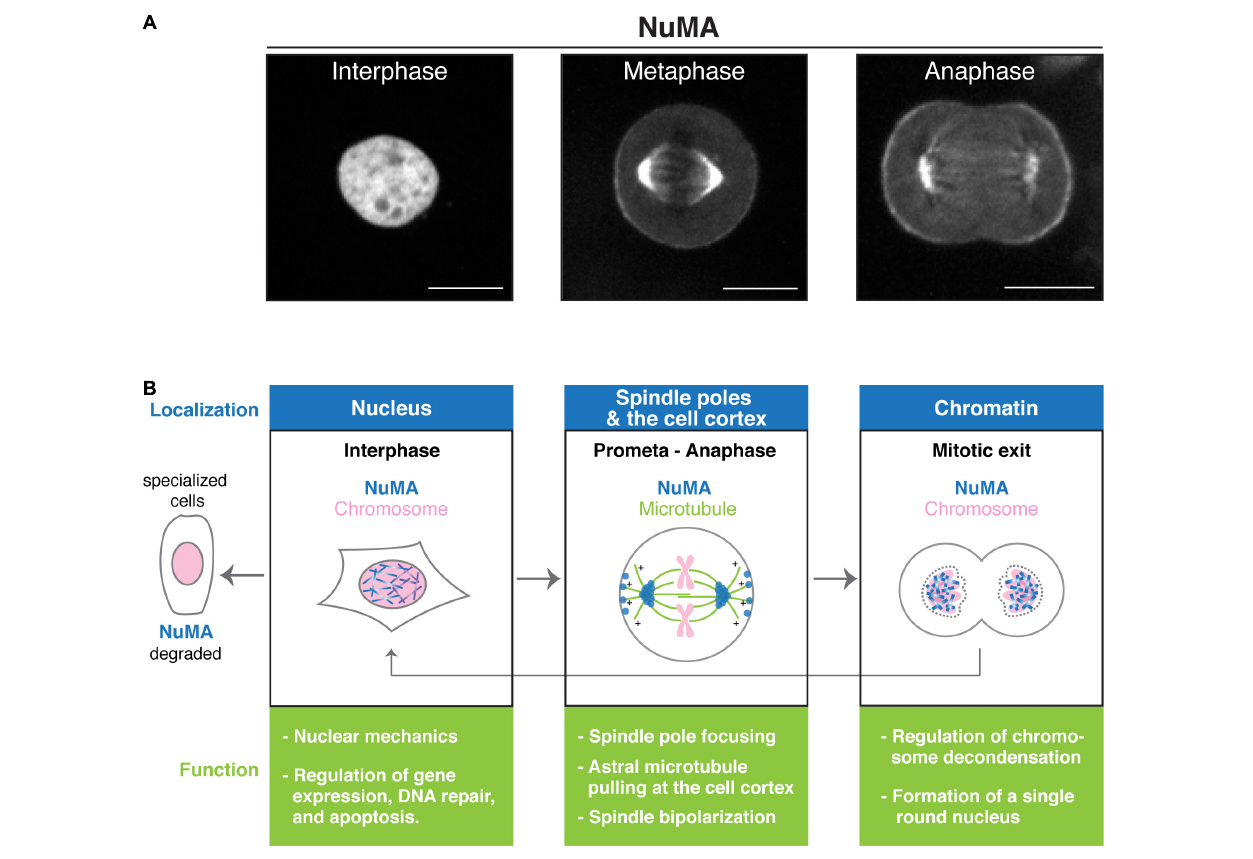
FIGURE 1 | Nuclear mitotic apparatus (NuMA’s) functions during the cell cycle. (A) Images of endogenous NuMA fused with mClover in human HCT116 cells (Okumura et al., 2018). NuMA accumulates in the nucleus in interphase, but mainly localizes at the spindle poles in metaphase. NuMA is also targeted to the cell cortex near the spindle poles during metaphase, and the level increases during anaphase (Collins et al., 2012; Kiyomitsu and Cheeseman, 2013; Kotak et al., 2013; Seldin et al., 2013; Zheng et al., 2014). Scale bars = 10 µ m. (B) Schematic showing how NuMA (blue) dynamically changes its subcellular localization during the cell cycle. Chromosomes and microtubules are shown in pink and green, respectively. Key functions of NuMA at these locations are